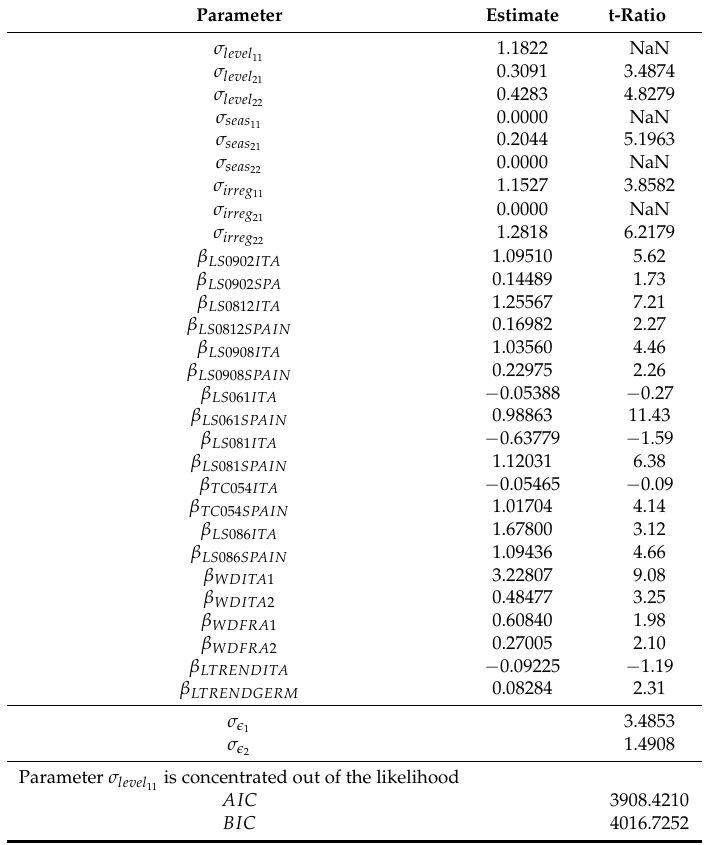
Table A7. Barebone model variables: IPI t intermediate goods LCVES t in